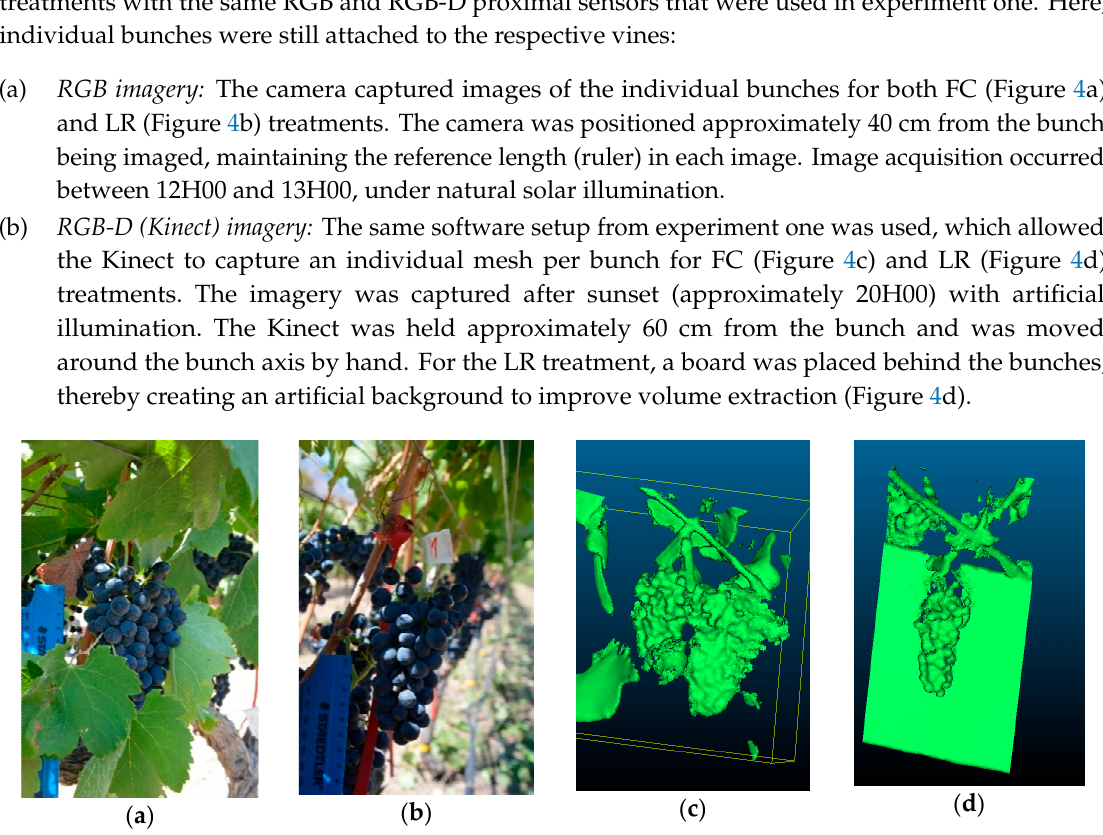
Figure 4. Data acquisition of individual bunches in the field. ( a ) RGB image with full canopy (FC); ( b ) RGB image with leaf removal (LR); ( c ) RGB-D (Kinect mesh) with FC; and ( d ) RGB-D (Kinect mesh) with LR.